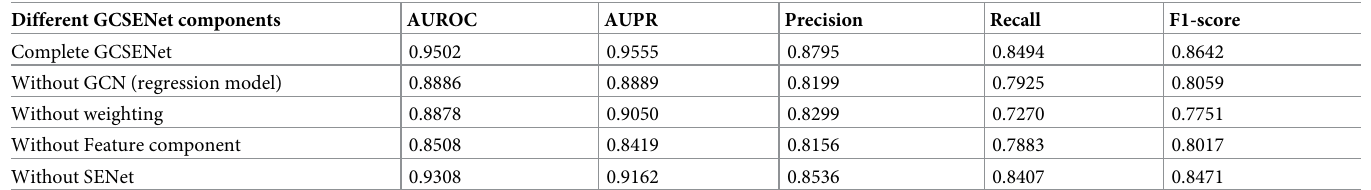
Table 1. Prediction performance comparison with different GCSENet components. Different GCSENet